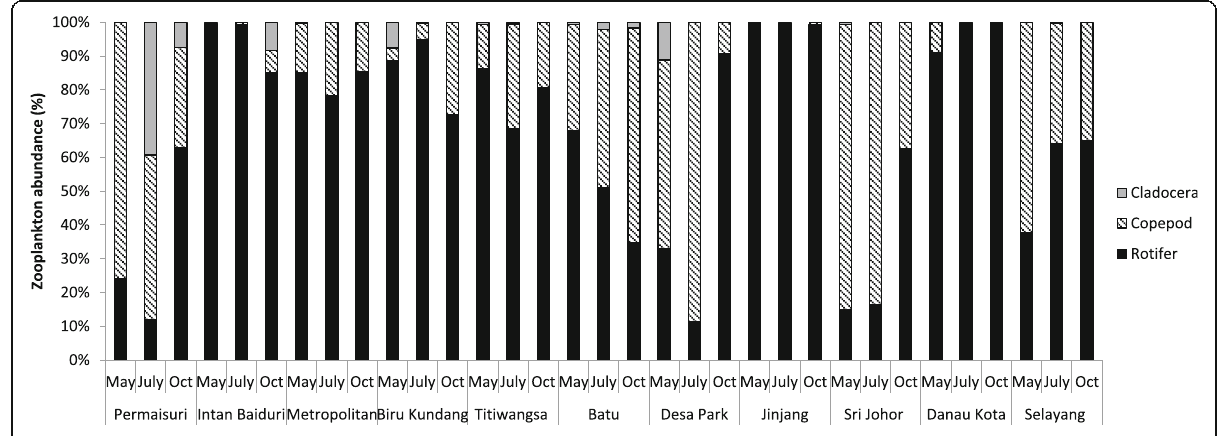
Fig. 3 Temporal abundance (%) of zooplankton groups in studied lakes and ponds